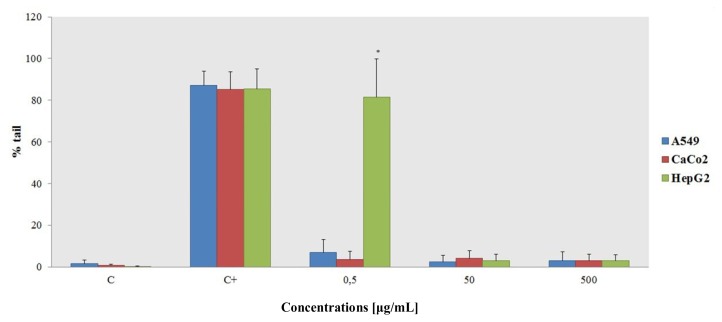
The Comet assay after the addition of 25 μM H2O2 to evaluate the protective ability of CeO2–NPs. The results are compared to the negative control and are the means ± SD for at least 3 replicates for each experimental point.